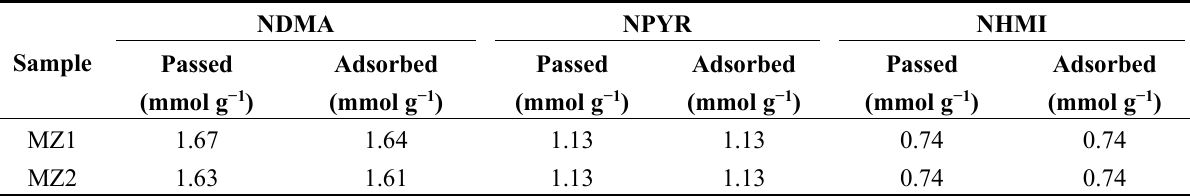
Table 2. Adsorption of three volatile N -nitrosamines by MZ1 and MZ2 samples.